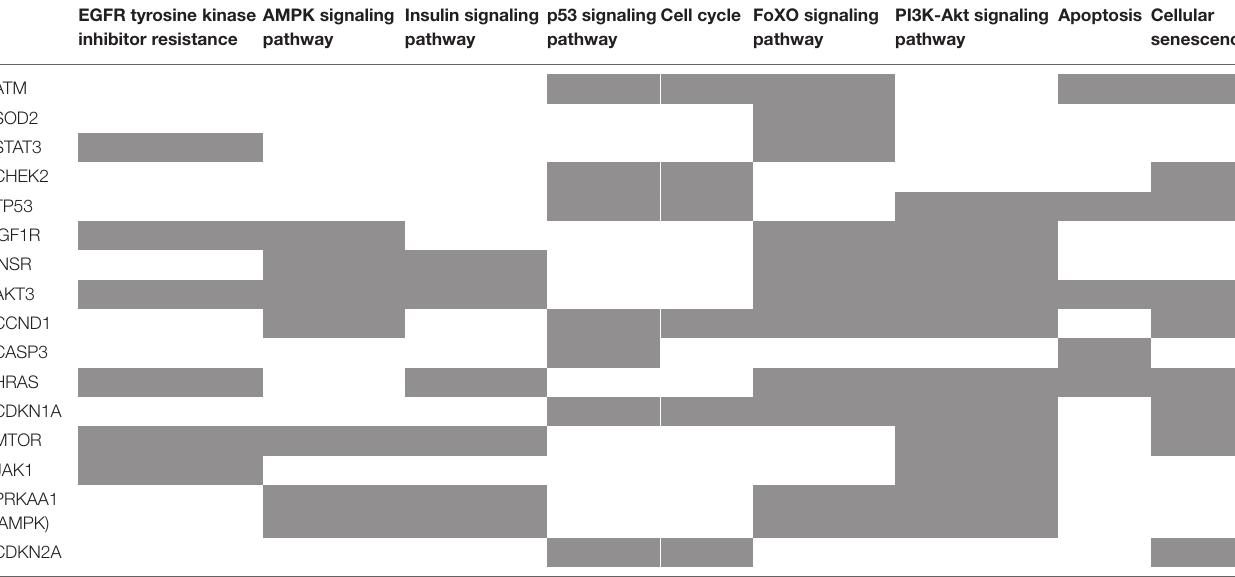
TABLE 1 | List of KEGG pathways analyzed by BioNSi (including 16 selected key